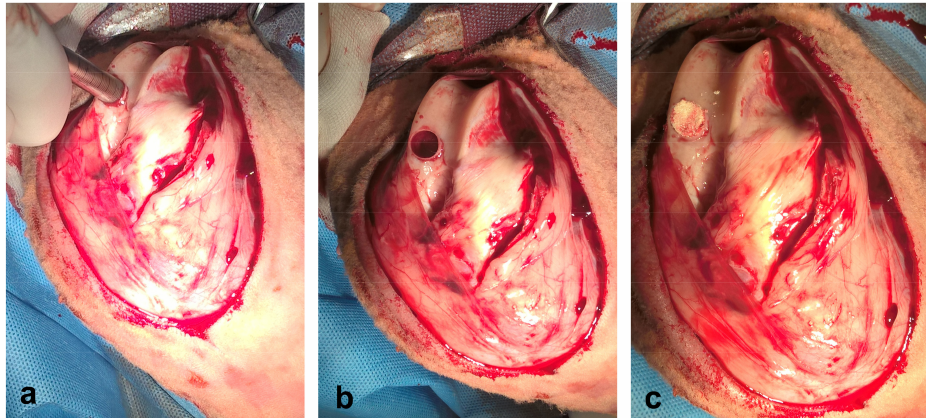
Figure 2. Surgical procedure: ( a ) inducing of articular cartilage defect with OATS equipment (Osteochondral autograft transfer system, Arthrex, Naples, FL, USA); ( b ) preparing articular cartilage defect in femoral trochlea before implantation; ( c ) inserting of scaffold into prepared articular cartilage